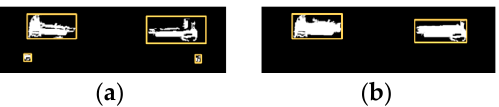
Figure 12. The detection results of the taillight pairs. ( a ) The result of the taillight pair detection using only the positional relationship constraint; ( b ) The results of the detection using the taillights of the method in this article.